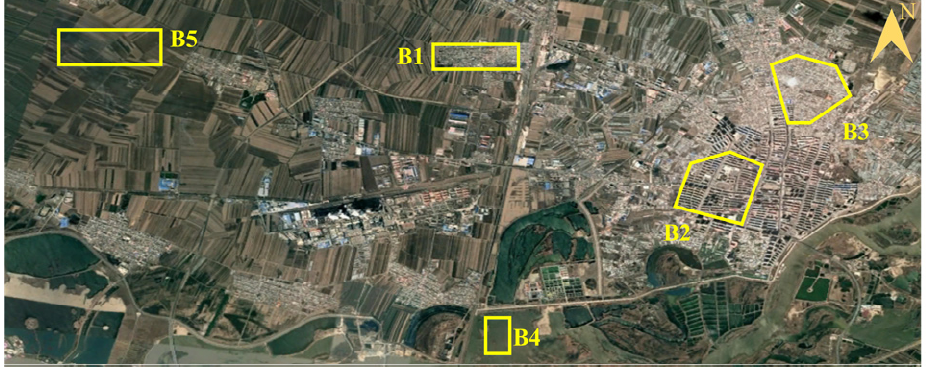
Figure 11. Optical image of GF-3 data sets from Google Earth.